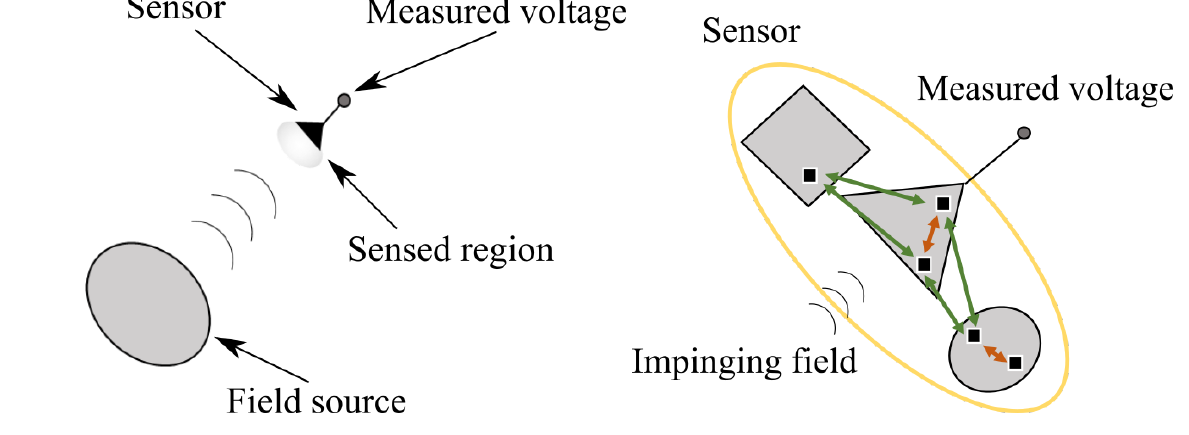
Figure 2. The sensing process as a scattering